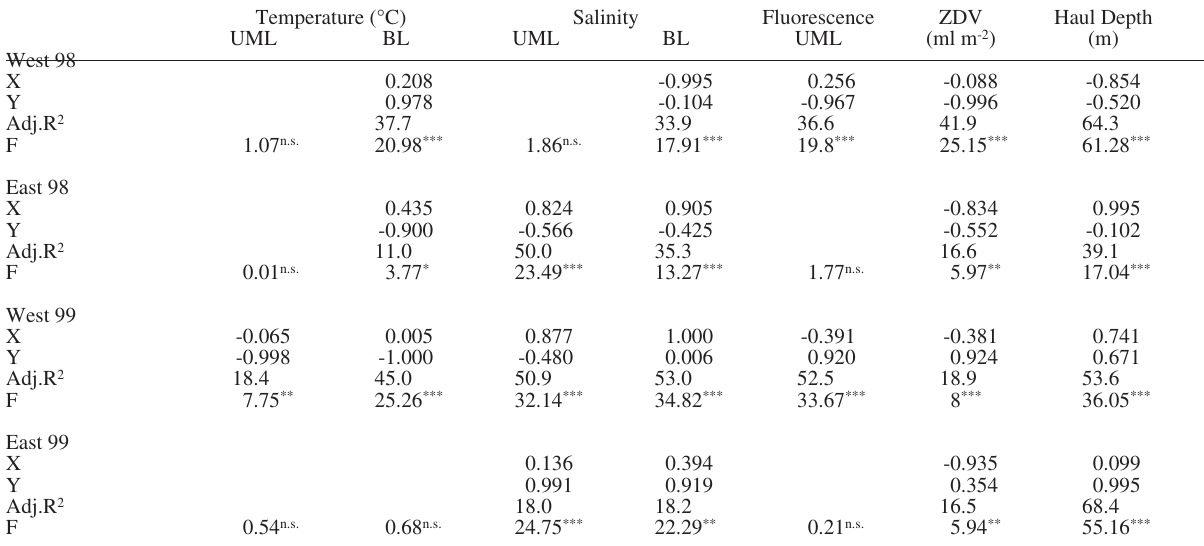
Fig . 8. – NMDS ordination plots of the comparison of sampling sites. The respective station groups defined by cluster analysis are indicated. Significant multiple regressions between ordination scores and the examined parameters are superimposed together with the fraction (%) of variance explained in each regression (Sal: salinity, Temp: temperature, F: integrated fluorescence, ZDV: zooplankton displacement volume, UML upper mixed layer. BL: bottom Table 2. – Multiple regression analysis between environmental parameters and the non-metric multidimensional scaling (NMDS) scores for two-axis ordination of sampling sites (X, Y: direction cosines) ( * , P<0.05; ** , P<0.01; *** , P <0.001; n.s. , not significant). Temperature (°C) Salinity Fluorescence